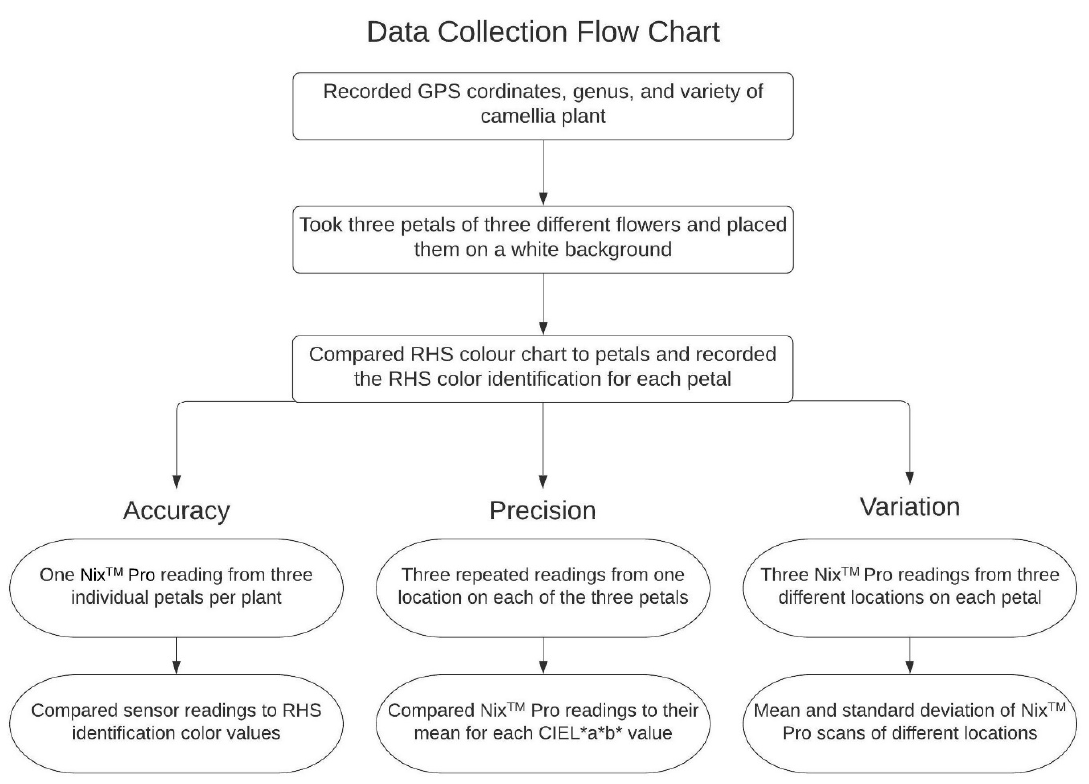
Figure 2. Flowchart of camellia petal color measuring methodology.